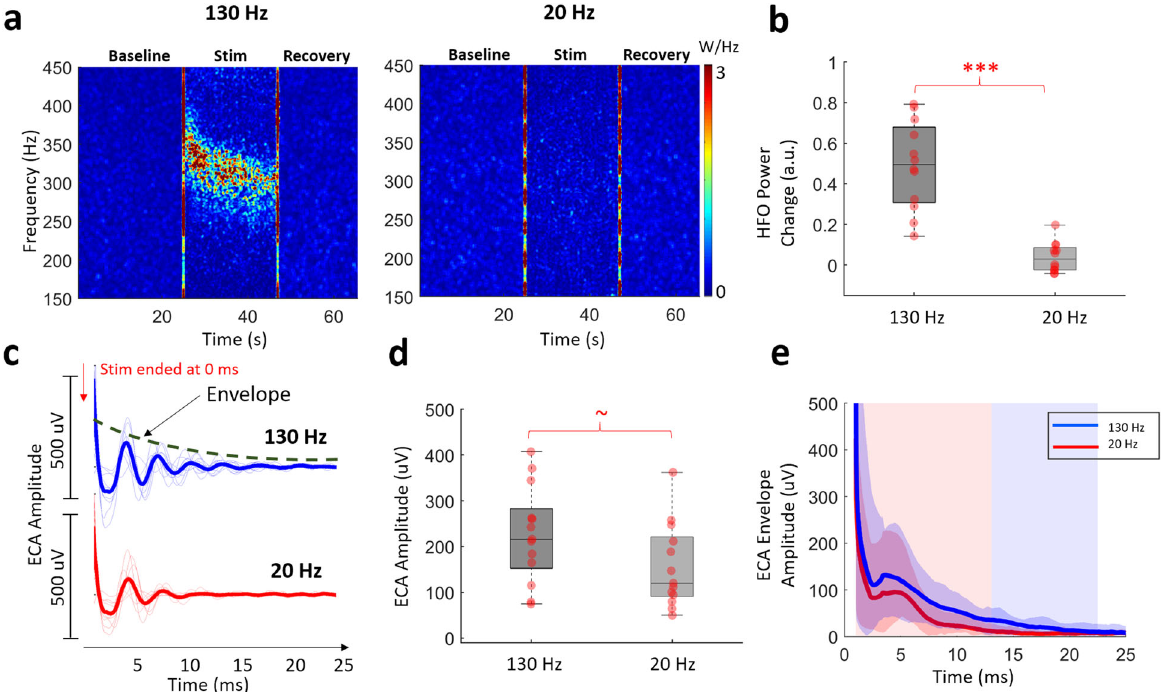
Fig. 3 Low-frequency DBS does not induce HFO but evokes compound activity that damped faster. a Representative TFMs of high- and low- frequency stimulation from a patient shows that HFO was induced only with the former. The large artifacts caused by harmonics of the stimulation frequency are interpolated. The vertical red lines on TFMs are the transition artifacts associated with turning the stimulator on and off. b The HFO power change was signi fi cantly higher with high-frequency stimulation ( n = 13). c Both high- and low- frequency stimulation induced ECA. The fi rst 1 ms after the stimulation pulse is omitted due to large artifact amplitude. d The difference between ECA amplitude after high- and low-frequency stimulation was only marginally signi fi cant ( n = 13). e The damping of ECA derived from the envelope of the Hilbert transform of the waveforms was signi fi cantly faster after low-frequency stimulation (mean ± standard deviation: 22.5 ± 5 vs. 13 ± 3.8 ms, n = 13). On each box in the boxplots, the central mark indicates the median, and the bottom and top edges of the box indicate the 25th and 75th percentiles, respectively. The whiskers extend to the most extreme data points not considered outliers, and the outliers are plotted individually using the “ + ” symbol. The individual data points are also plotted as red circles. ~ denotes p < 0.06, *** denotes signi fi cance